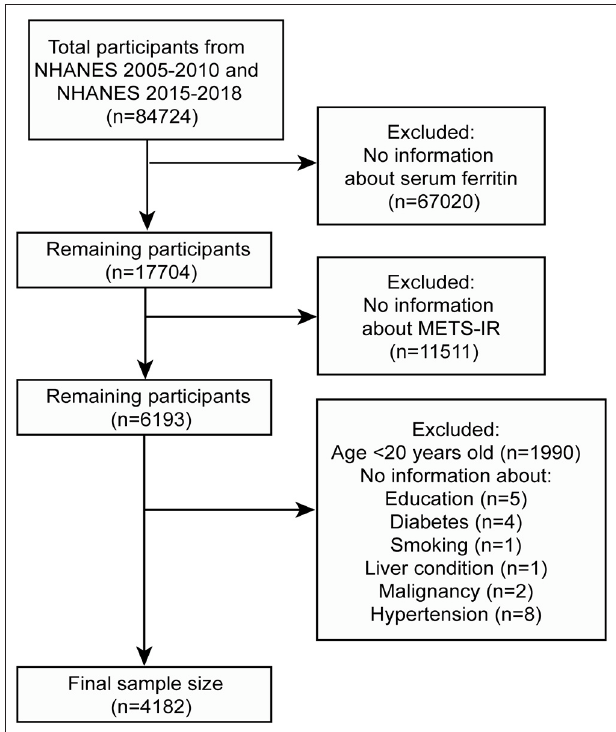
FIGURE 1 | Flow chart for